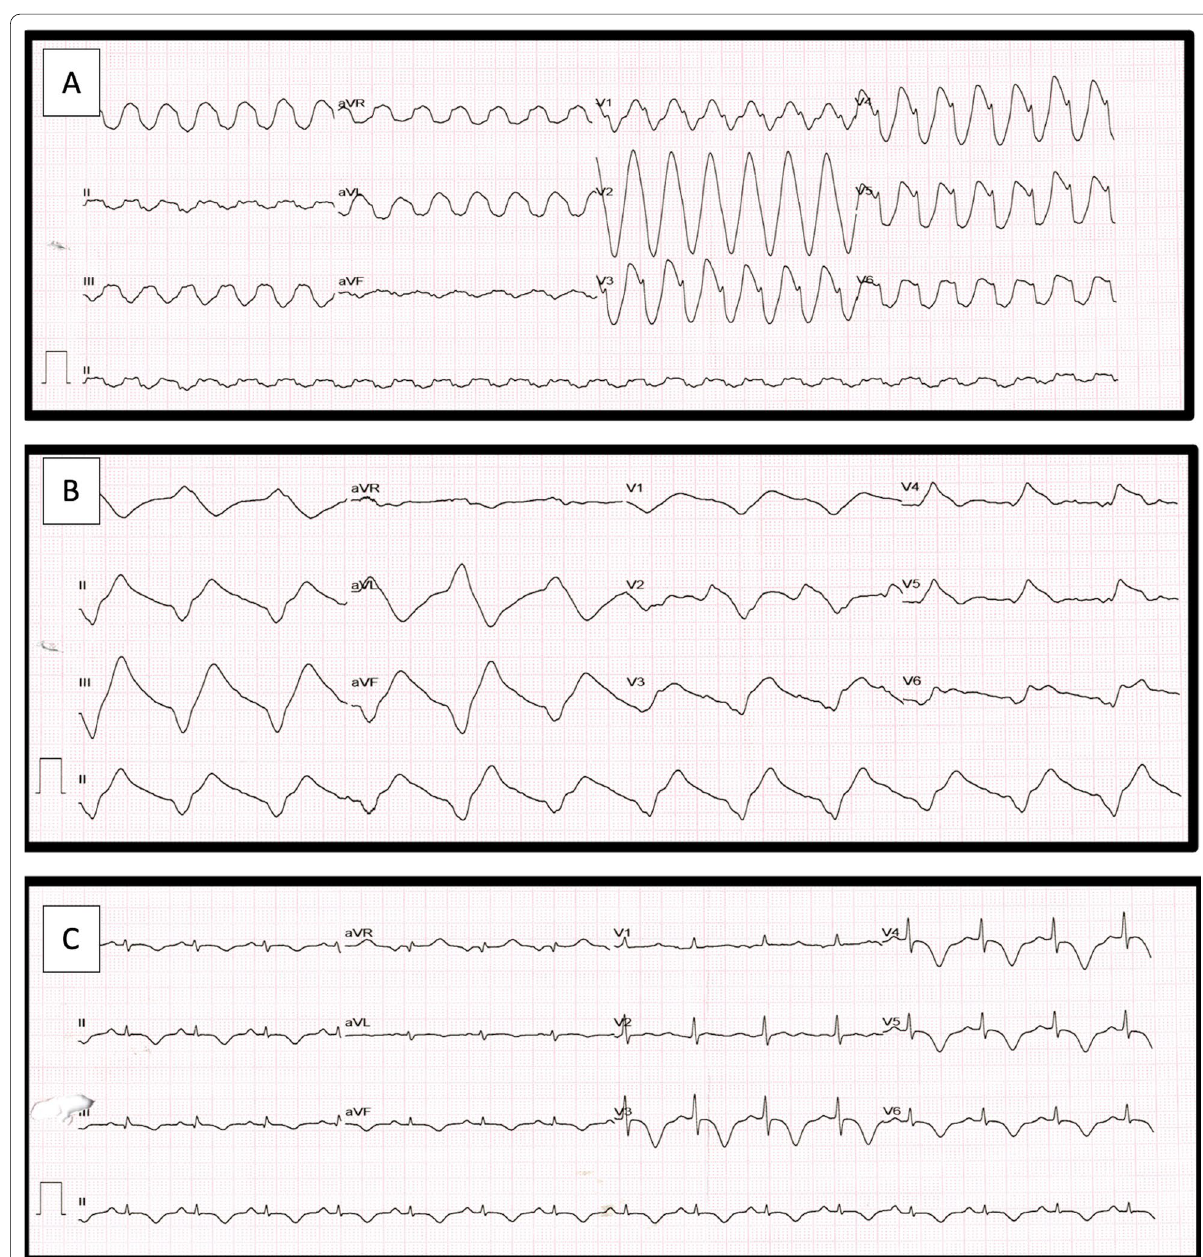
Fig. 2 Electrocardiogram of the patient showed monomorphic ventricular tachycardia upon presentation ( A ). Post-electrical cardioversion, there was sine-wave pattern on the electrocardiogram consistent with severe hyperkalemia ( B ). Serum potassium at the time was 7.8 mEq/L. The electrocardiogram after potassium correction revealed T-wave inversions in the anterior and inferior leads with a prolonged QT C of 530 ms ( C